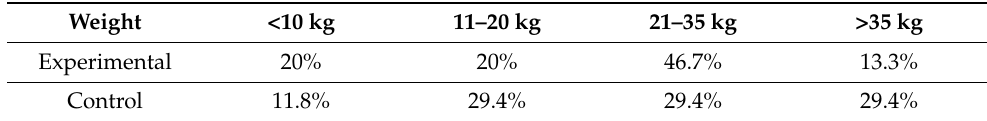
Table 3. Weight of male dogs (experimental and control